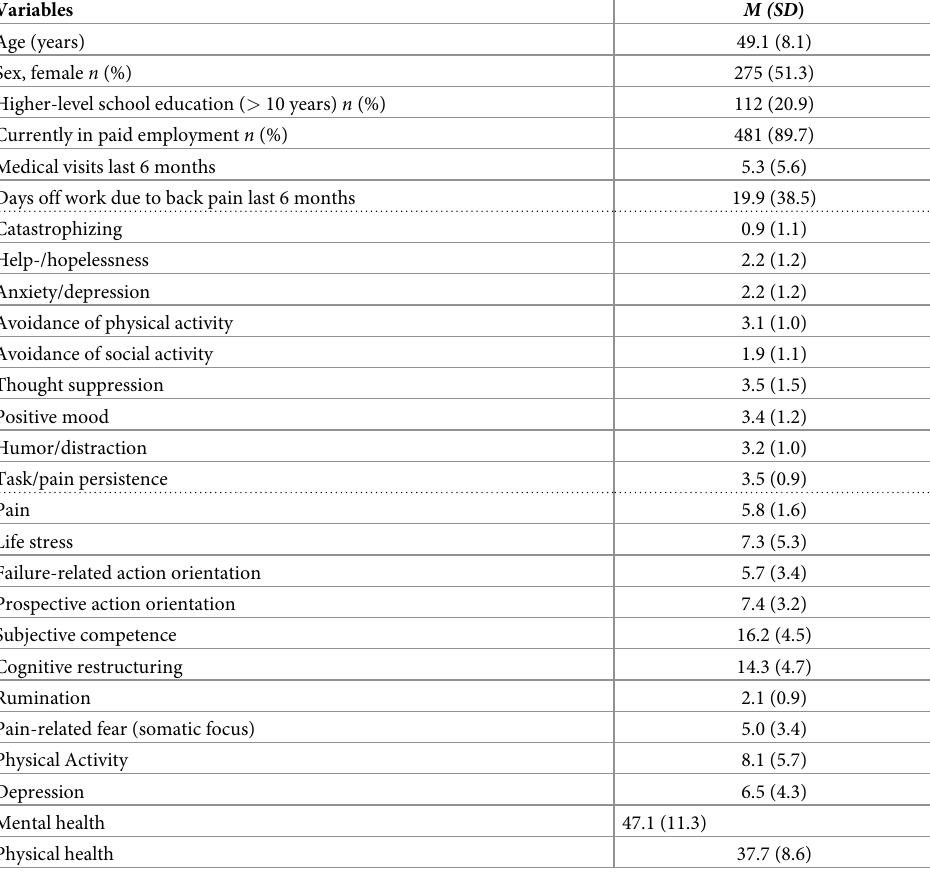
Table 2. Frequencies, means and standard deviations in socio-demographical, medical, primary response, and secondary variables.